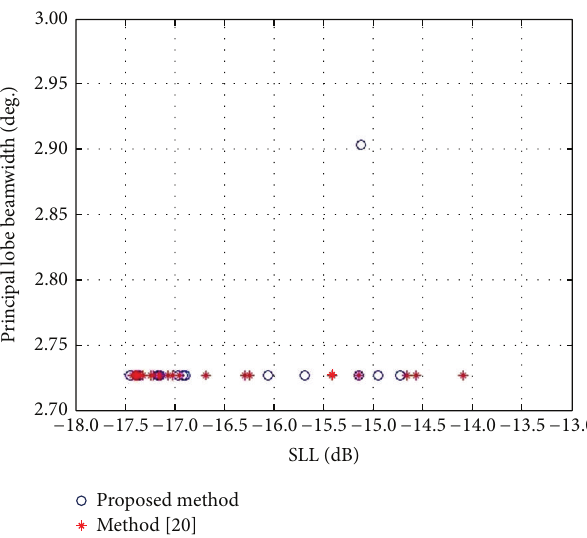
Figure 7: The beamwidth comparison of linear array with 25